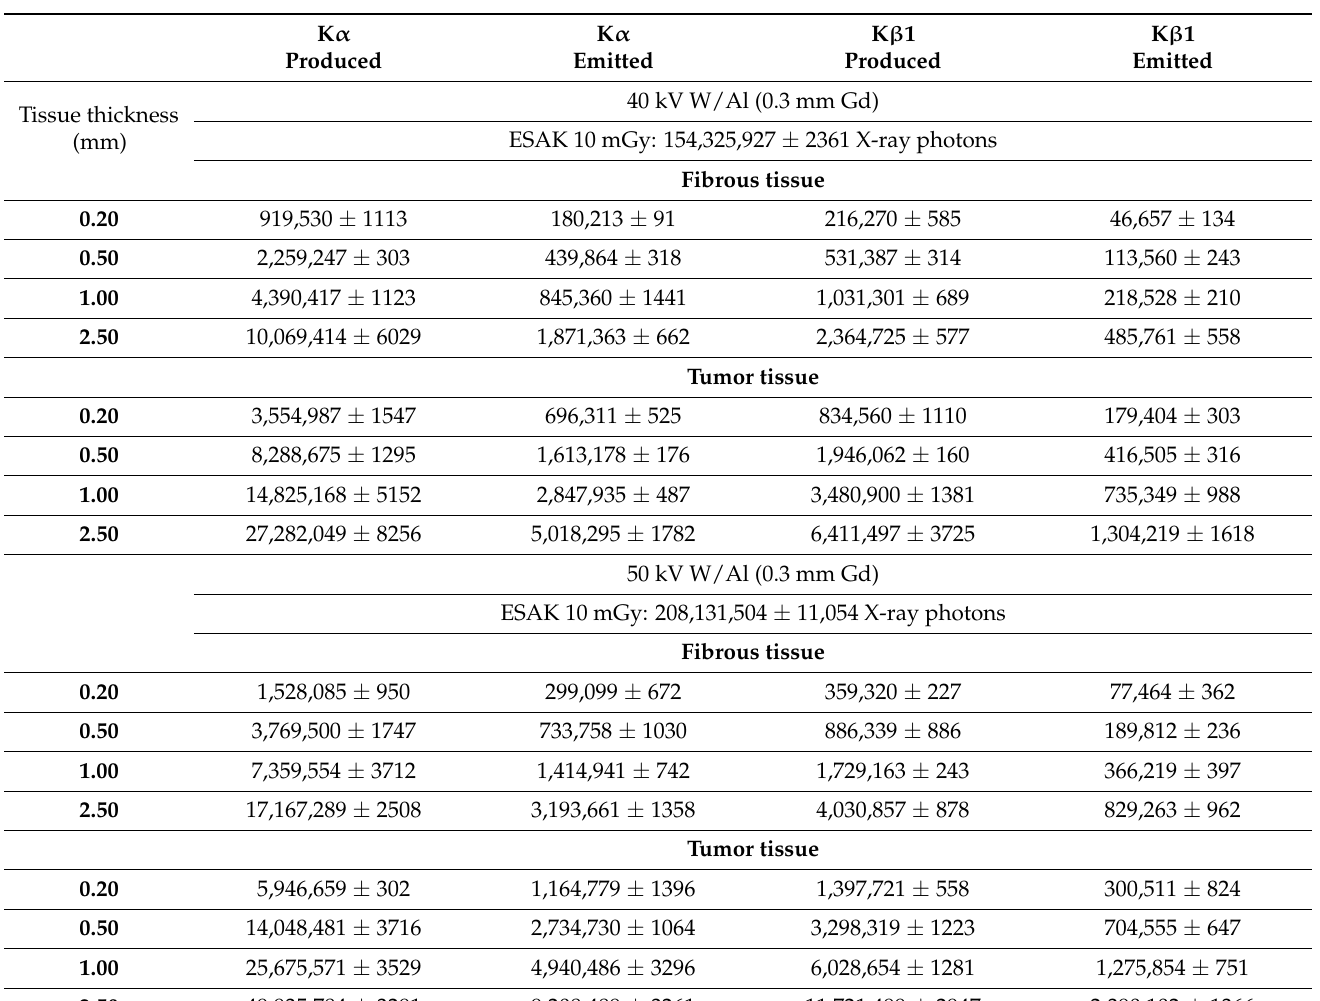
Table 2. Table shows the number of Iodine K -X-rays ( K α and K β 1 ) produced and emitted as well as the initial number of X-ray photons (corresponding to 10 mGy ESAK). Results are provided for: (a) two X-ray spectra: 40 kV- W/Al (1.6 mm) and 50 kV- W/Al (1.6 mm) with additional filtration 0.3 mm Gd; (b) two types of internal tissue (fibrous and tumor) with thicknesses ranging from 0.2 mm up to 2.5 mm; and (c) external fat tissue of 4 cm thickness. Numerical values are expressed by the mean value and their corresponding standard